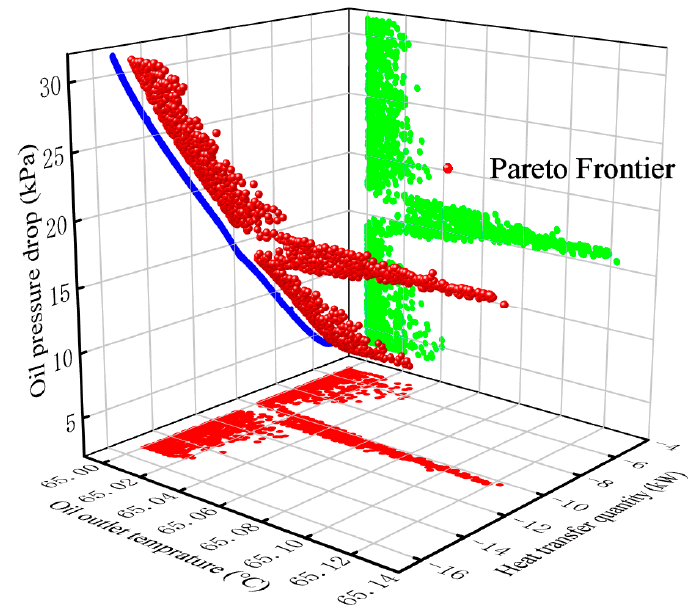
Figure 8. The distribution of Pareto optimal solutions.